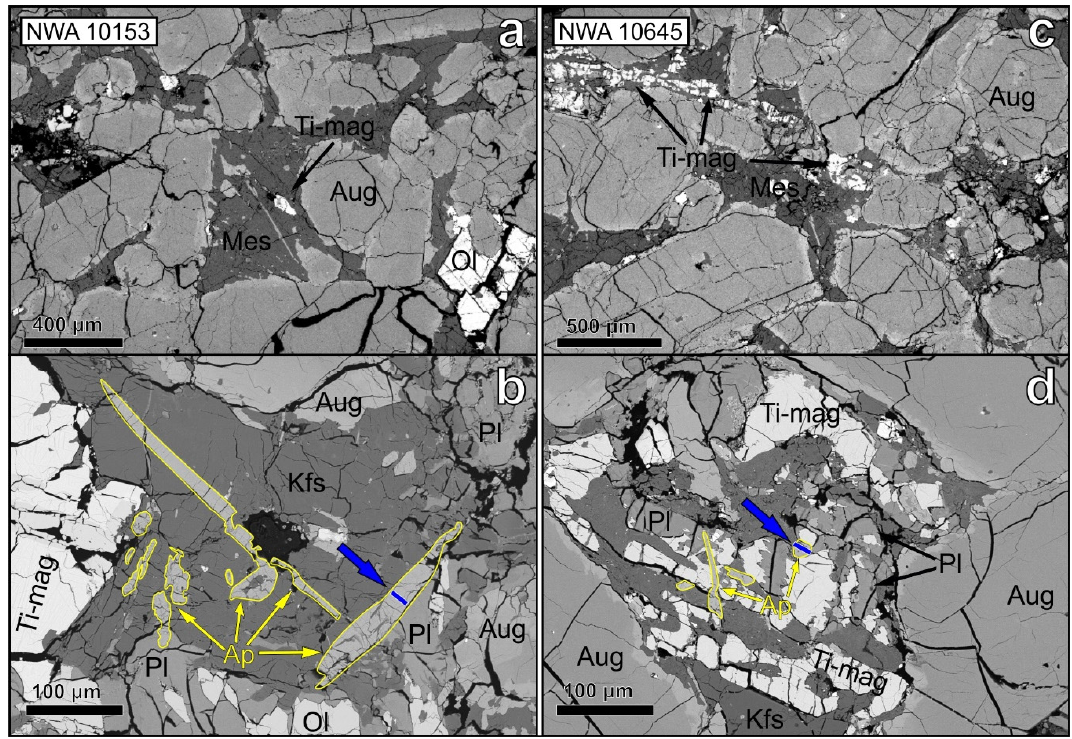
Figure 1. BSE images of typical mineral assemblages in NWA 10153 ( a , b ) and NWA 10645 ( c , d ). The blue blocks and arrows indicate the position of lifted TEM foils. Abbreviations according to Whitney and Evans [40]: Ap—apatite (predominantly Cl-rich fluorapatite), Kfs—alkali feldspar (Ab 40.4 Or 56.2 ), Aug—augite (Fs 23.1-48.9 Wo 33.3-41.1 ), Mes—mesostasis, Pl—plagioclase (An 23.4-25.4 Ab 71.3-73.0 Or 5.3-3.4 ), Ol—olivine (cores Fa 61.3-63.7 , rims Fa 76.2-81.8 ), Ti-mag—titanomagnetite.